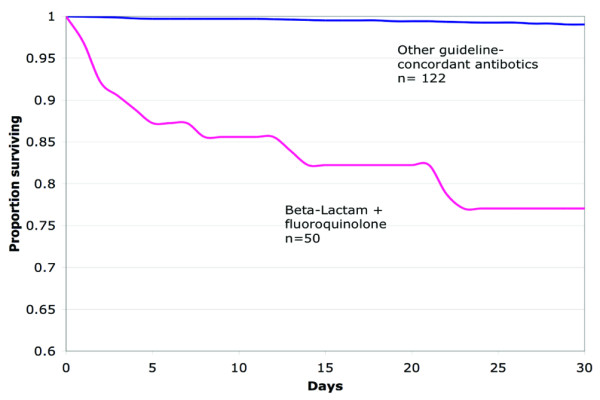
Proportion of surviving patients hospitalized with severe community-acquired pneumonia by antibiotics received (p = 0.004).